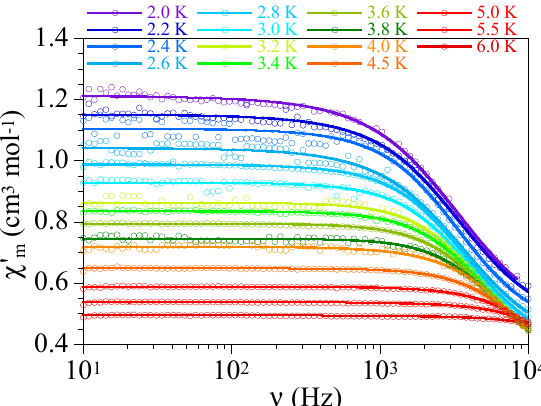
Figure 6. Frequency dependence of the in-phase AC susceptibility for 1 with an applied DC field of 800 Oe at different temperatures. Solid line is the best fit to the Debye model (Equation (2)).